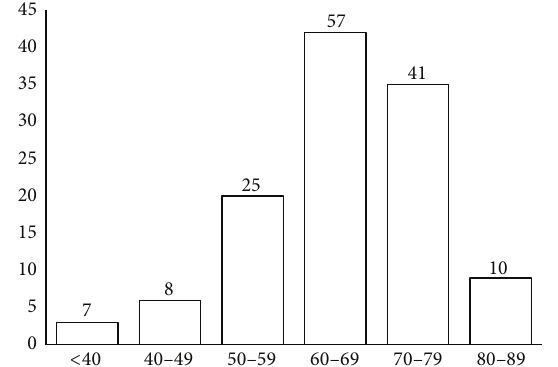
Figure 1: Age distribution of patients with bladder cancer.